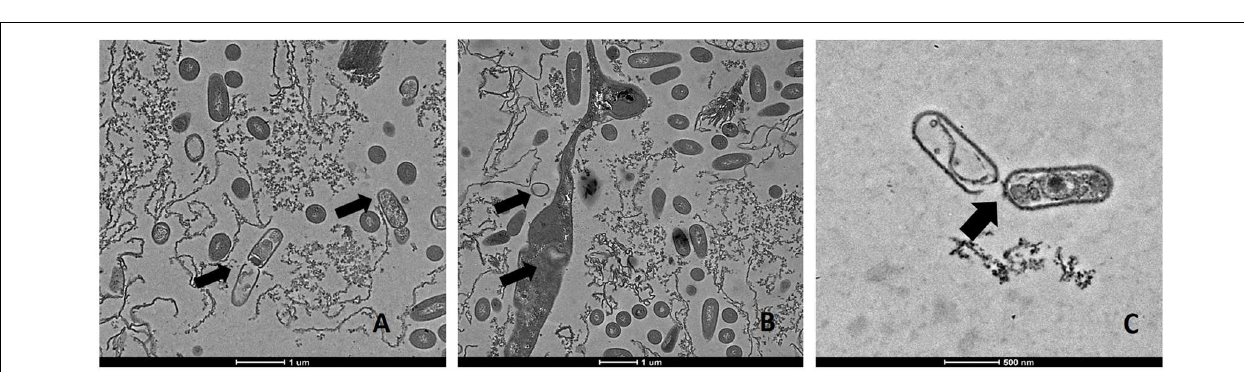
FIGURE 5 | Transmission electron microscopy (TEM) micrographs of pulsed-light exposed L. monocytogenes Li-P69 cells treated with 2.6 J cm − 2 for 5 s. Scale bar equals 1 µ m (A,B) and 500 nm (C) . Arrows indicate irreversible damage to bacterial cells, melting structures, and ghost cells (empty envelope